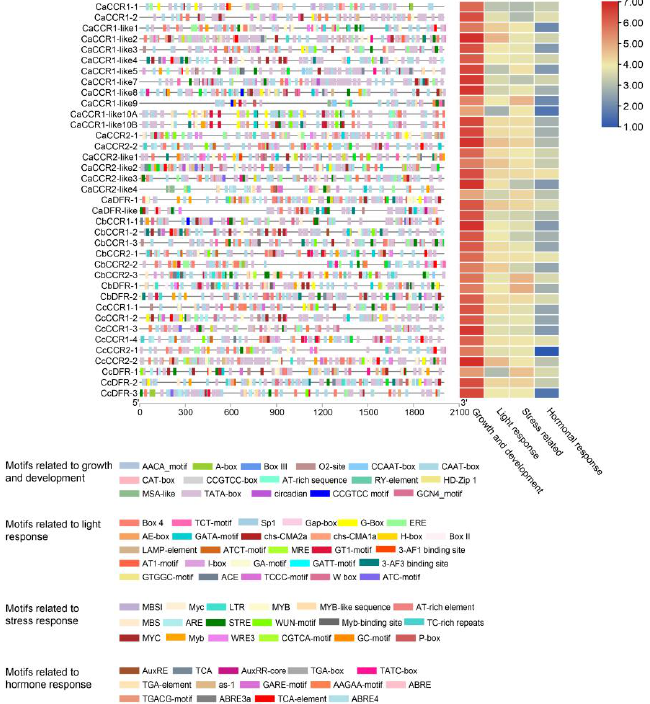
Figure 2. Analysis of cis acting elements of the promoter from the pepper CCR and CCR-like gene